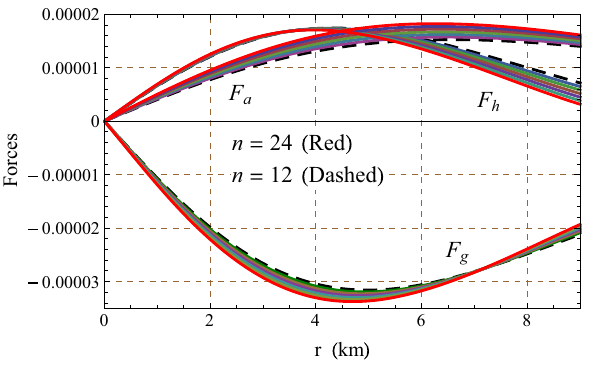
Fig. 12 Variations of gravitational, hydrostatic and anisotropic forces acting on the system with radial coordinate for the parameters given in